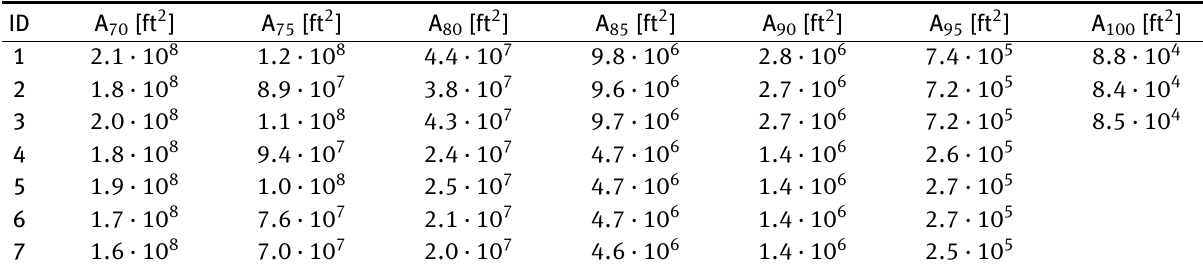
Table 9: SEL contoured areas for Cessna T206H Stationair. Case ID corresponding to Table 6. ID